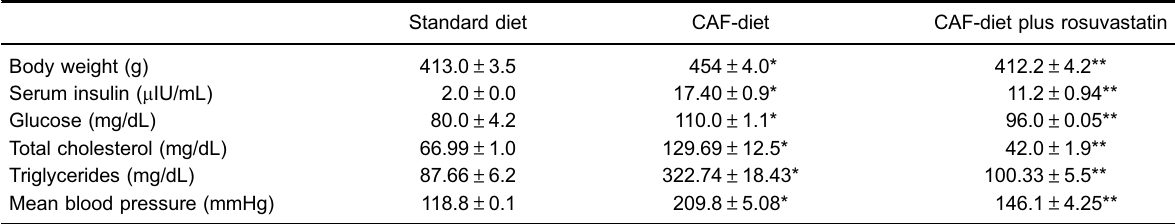
Table 1. Metabolic parameters of three groups of male Wistar rats on a 16-week regimen, including the standard diet, the cafeteria-style (CAF)-diet, and the CAF-diet plus rosuvastatin treatment. Standard diet